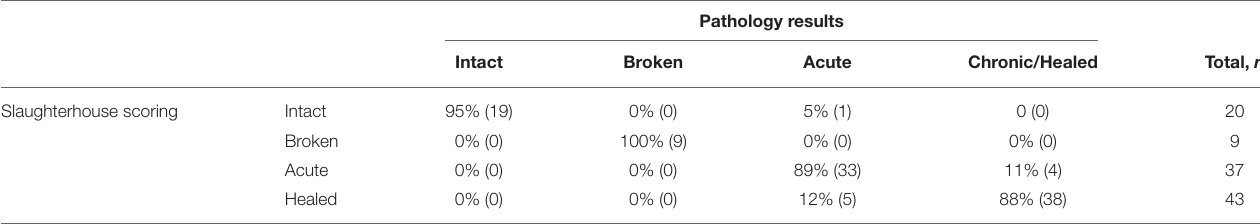
TABLE 3 | Comparison between the tail scoring results of finishing pigs obtained at the slaughterhouse and during pathological evaluation ( n = 109).